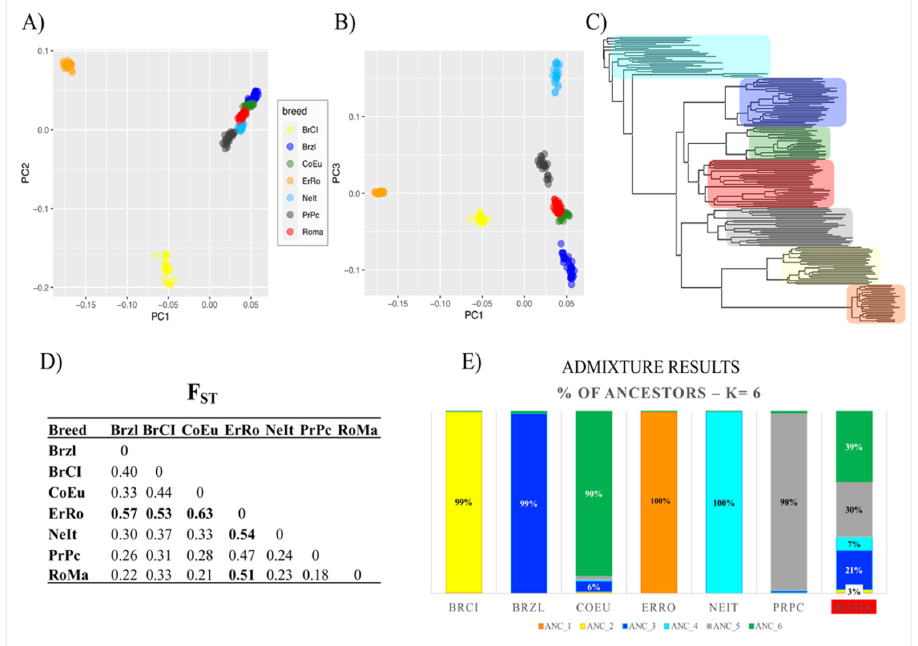
Figure 1. Breeds’ genetic diversity based on SNP markers. ( A ) PCA 2D result: PC1 (eigenvalues = 18.70; 29.02% of total genetic variability) vs. PC2 (eigenvalues = 10.41; 16.16% of total genetic variability); ( B ) PCA 2D result: PC1 vs. PC3 (eigenvalues = 8.44; 13.09% of total genetic variability); ( C ) NJ tree built using the identity-by-state genetic distance matrix (breeds are coloured as in PCA); ( D ) FST results: in bold FST values >0.5; ( E ) ADMIXTURE result: proportion (more relevant values are reported) of ancestors identified (“ANC_n.”) at K = 6, where the lowest CV error value was found.